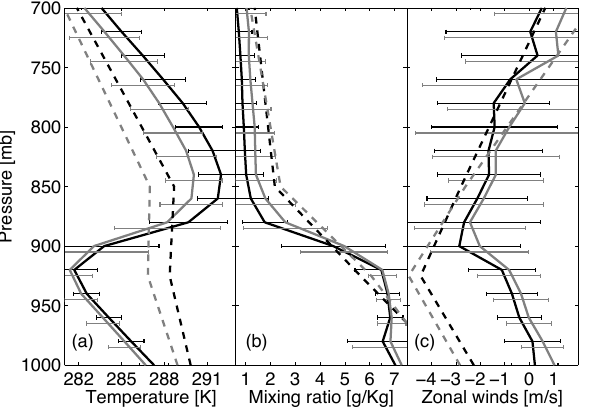
Figure 6. Antofagasta radiosonde (solid) and NCEP reanalysis (dashed) MAX-N d (black) Fig. 6. Antofagasta radiosonde (solid) and NCEP reanalysis and MIN-N d (grey) composites of a) temperature, b) mixing ratio, and c) zonal winds. (dashed) MAX- N d (black) and MIN- N d (grey) composites of (a) Antofagasta (23.5˚S, 70.5˚W) radiosondes launched at 1200 UTC (0800 LT). NCEP- temperature, (b) mixing ratio, and c) zonal winds. Antofagasta NCAR reanalysis data from 22.5˚S, 75˚W. (23.5 ◦ S, 70.5 ◦ W) radiosondes launched at 12:00,UTC (08:00LT). NCEP-NCAR reanalysis data from 22.5 ◦ S, 75 ◦ W.